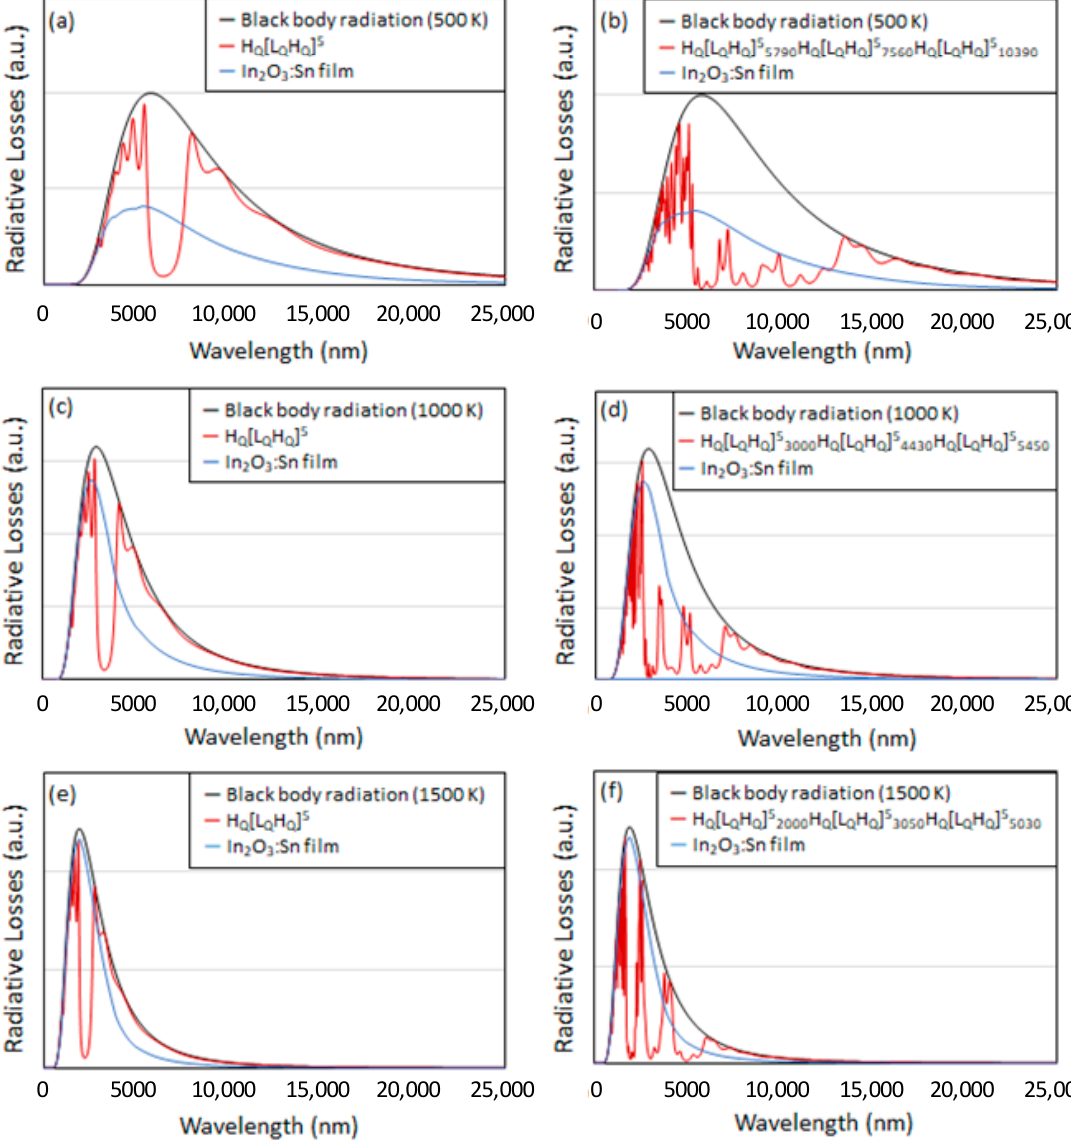
Figure 4. The radiation spectra from a blackbody receiver at ( a ) 500 K, ( b ) 1000 K, and ( c ) 1500 K when it is not covered (black line), when it is covered with a In 2 O 3 :Sn film (blue line) and when it is covered with H Q [L Q H Q ] 5 . Also shown is the radiation spectra from a blackbody receiver at ( d ) 500 K, ( e ) 1000 K, and ( f ) 1500 K when it is not covered (black line), when it is covered with a In 2 O 3 :Sn film (blue line) and when it is covered with H Q [L Q H Q ] 5 5790 · H Q [L Q H Q ] 5 7060 · H Q [L Q H Q ] 5 9540 (red line in “d”), H Q [L Q H Q ] 5 3000 · H Q [L Q H Q ] 5 4430 · H Q [L Q H Q ] 5 5450 (red line in “e”),